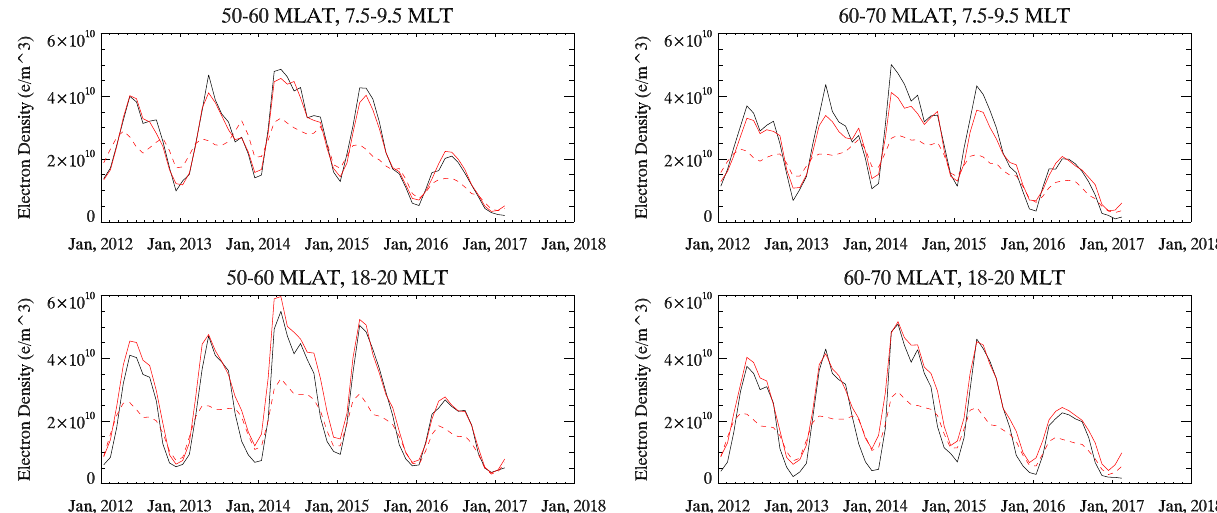
Fig. 5. Same as Figure 4, but for DMSP satellite F18. The top plots correspond to the 7.5 – 9.5 MLT bin, the bottom plots correspond to the 18 – 20 MLT bin, the left plots are for the 50 (cid:1) – 60 (cid:1) N geomagnetic latitude bin, and the right plots are for the 60 (cid:1) – 70 (cid:1) N geomagnetic latitude bin.